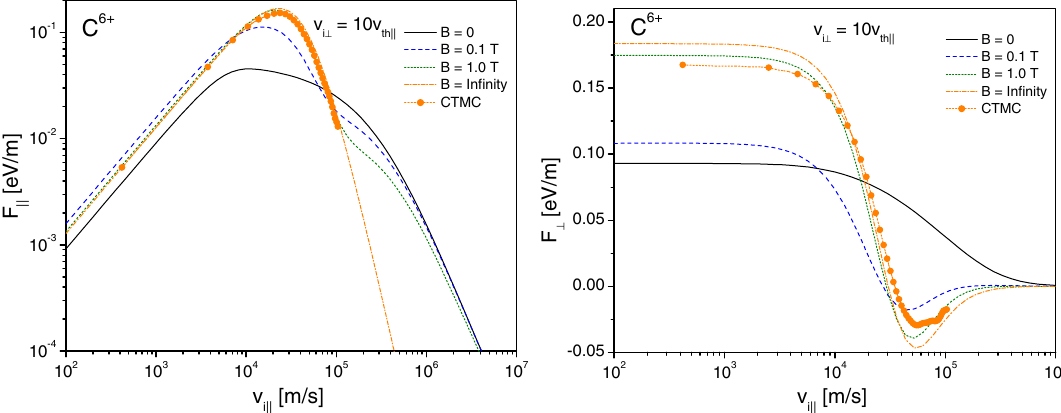
¼ 10 v th k .Notethatintherightpanelthetransverseforcefor i ?